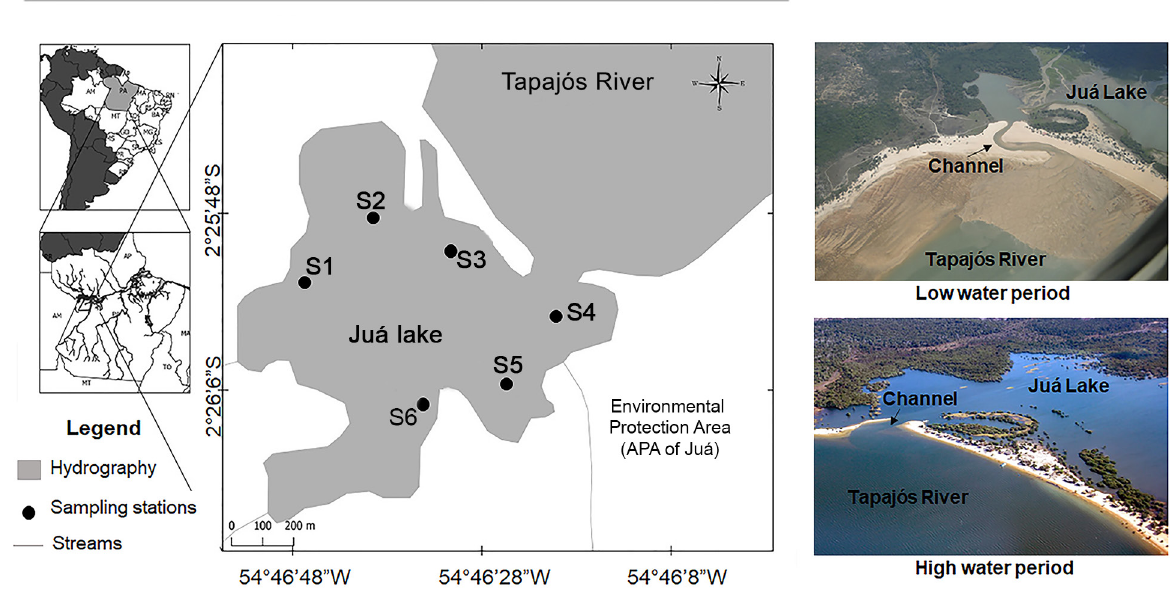
Figure 1. Study area with emphasis on Lake Juá located at the mouth of the Tapajós River and the distribution of sampling points. Photos of Manuel Dutra (low water) and Celso Lobo (high